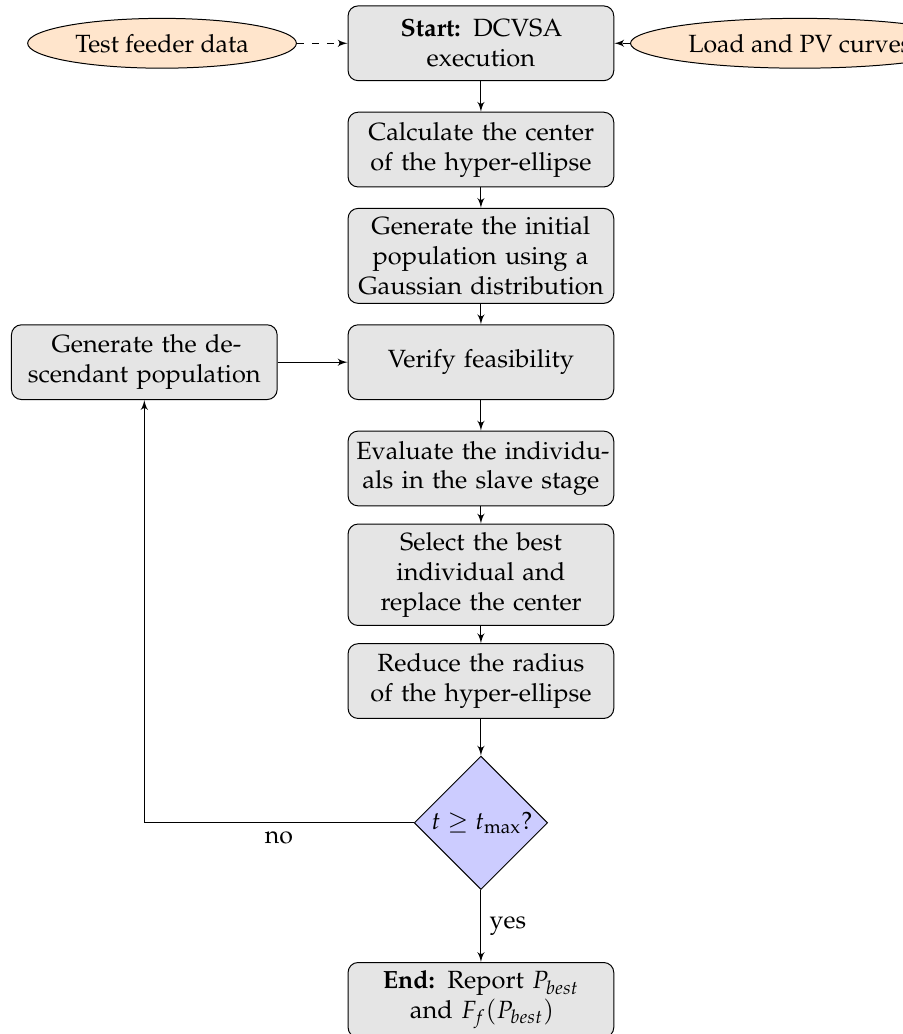
Figure 1. General implementation of DCVSA to solve optimization problems in distribution